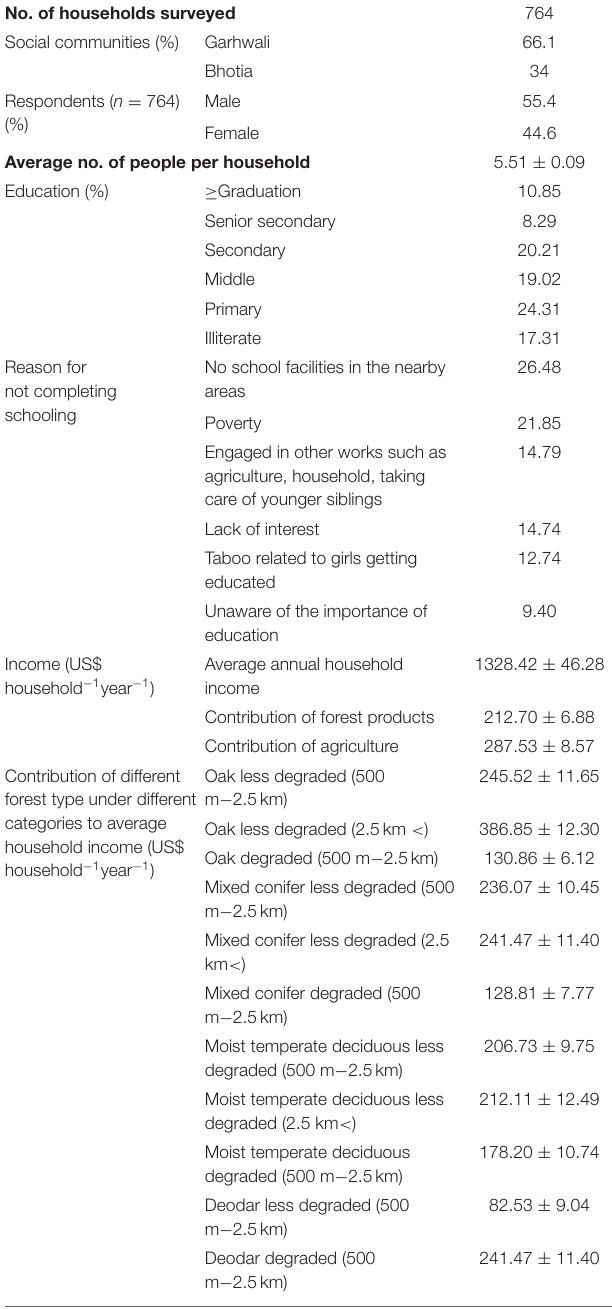
TABLE 2 | Profile of households surveyed to assess status of human wellbeing in Nanda Devi Biosphere